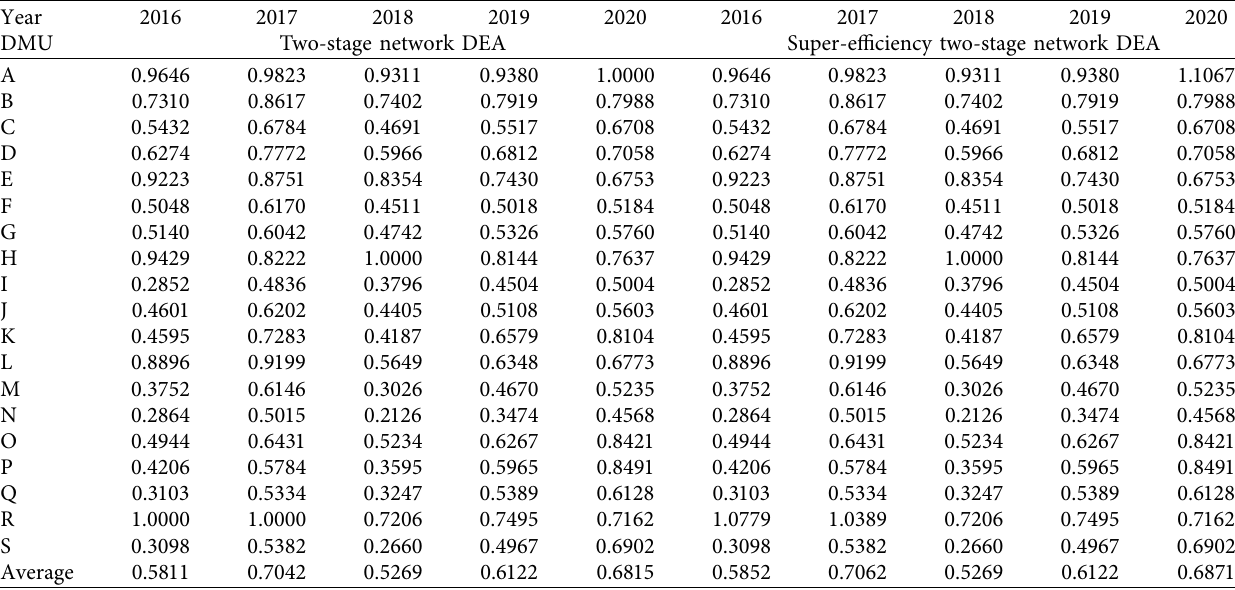
Table 3: Measurement results of various banks in stage 2.